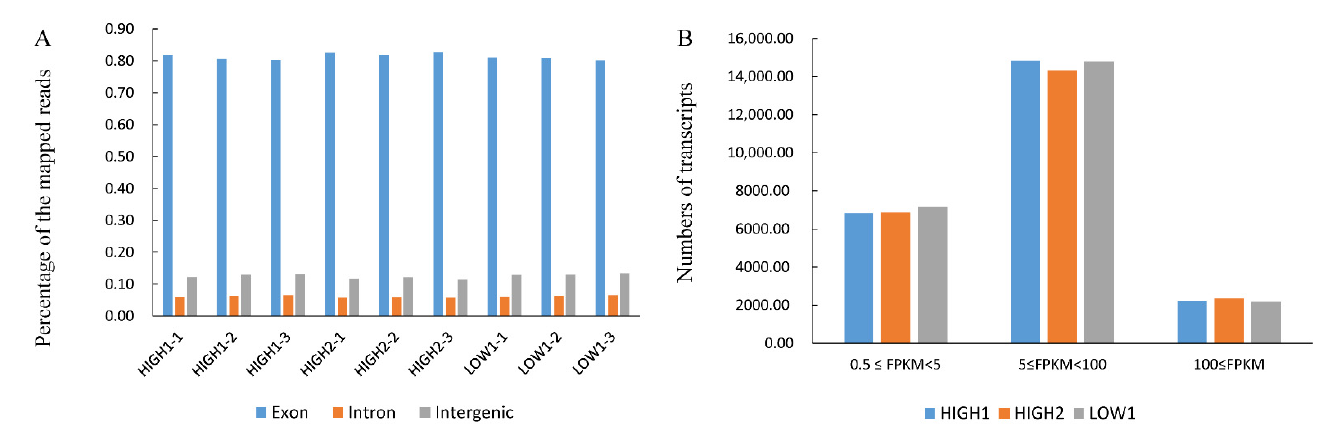
Figure 2. Transcriptome analysis of fleshy taproots of three radish genotypes. ( A ) Percentages of the mapped reads distributed in different sites (intron, intergenic, and exon) of genes in HIGH1, HIGH2, and LOW1. The x axis represents three replicates of the sequenced varieties—namely, HIGH1, HIGH2, and LOW1. The y axis shows the percentage of mapped reads distributed in different sites of genes. ( B ) Numbers of transcripts with different FPKM values in the roots of the three cultivars. The x axis represents the sequenced genotypes—namely, LOW1, HIGH1 and HIGH2. The y axis shows the numbers of transcripts. The different colors represent the different FPKM values.